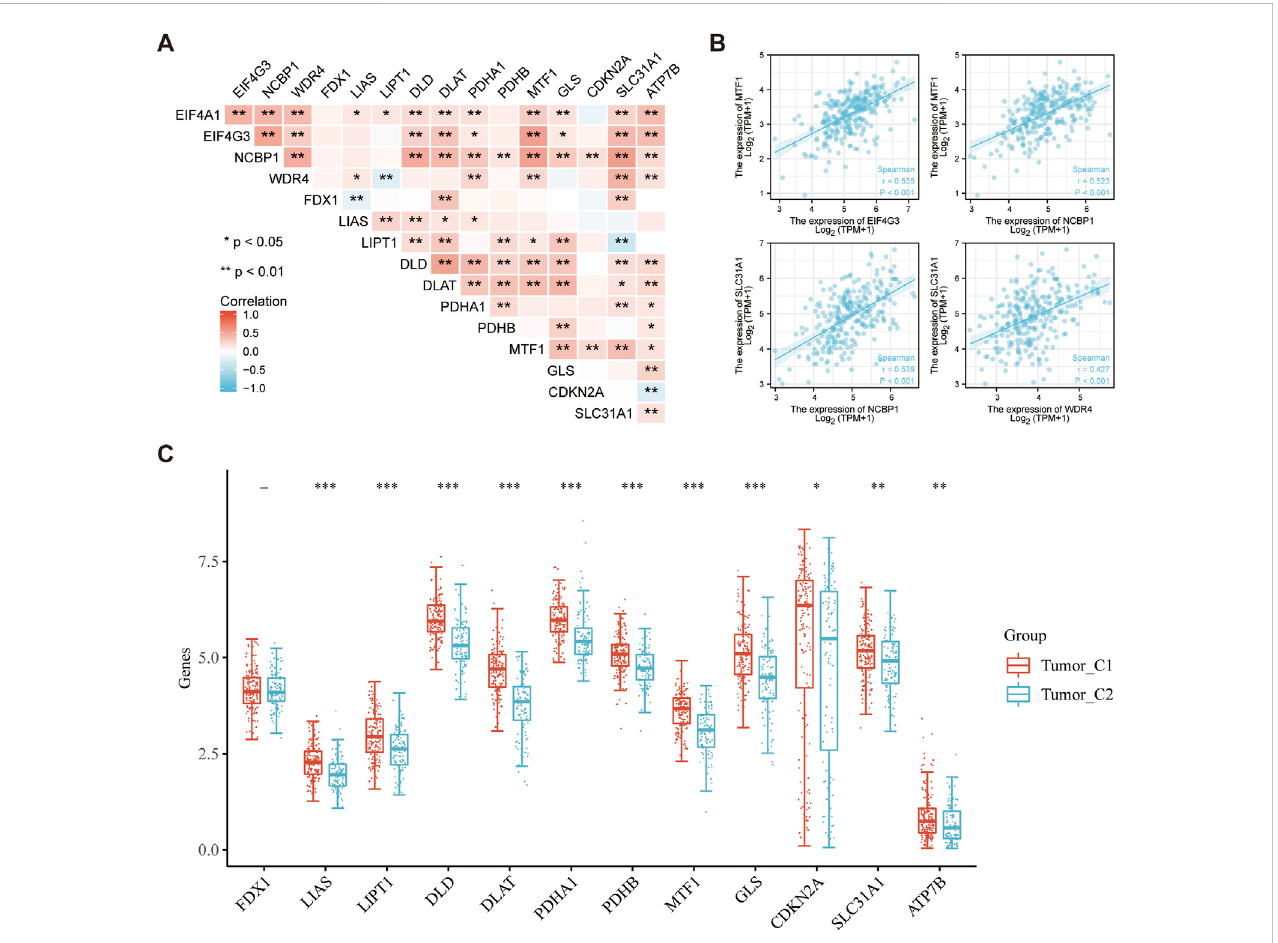
FIGURE 12 Signi fi cant correlation between m7GRGs and cuproptosis-related genes. (A) Heat map showing correlation between m7GRGs and cuproptosis-related genes; (B) Scatter plot of correlation between prognotic m7GRGs and cuproptosis-related genes; (C) Differential expression of cuproptosis-related genes between C1 and C2